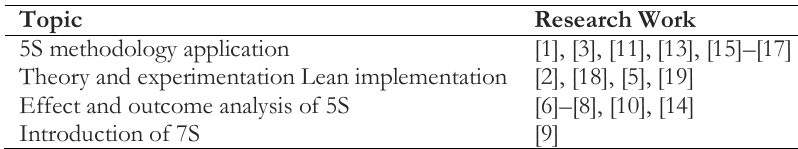
Table 1. Overview of literatures.